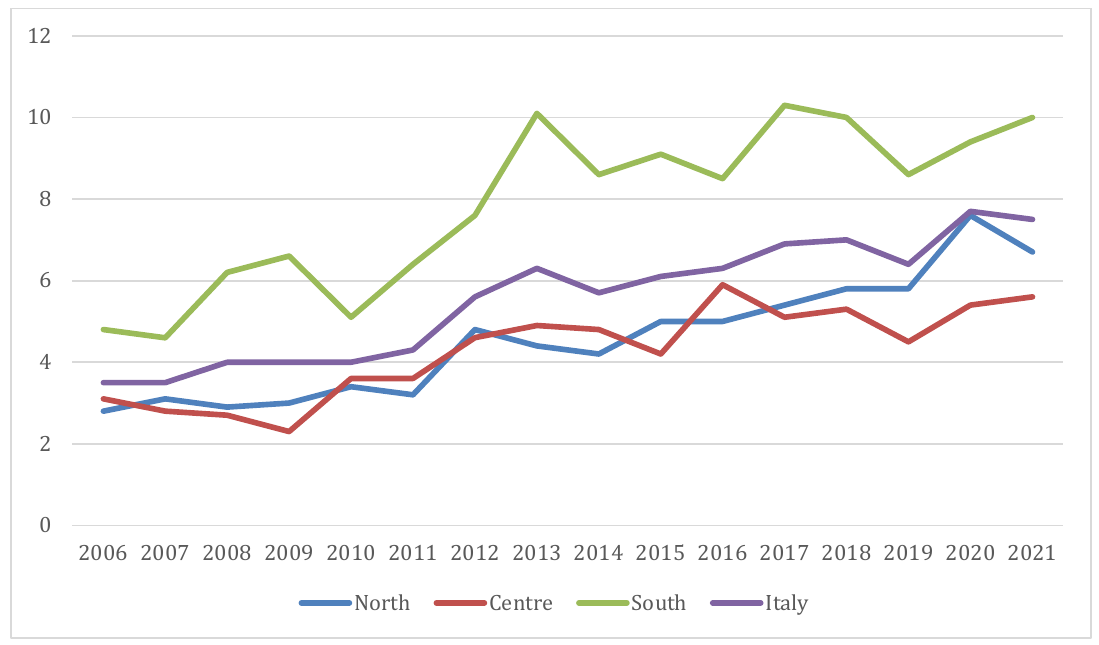
024681012 Figure 1. Poverty rate trends in Italy, 2005–2021. Source: own elaboration on the Istat database. From 2020, the poverty rate decreased by 0.2 percentage points for individuals and kept the same percentage for households. The rate in southern Italy increased from 9.4% to 10% for individuals and from 11.1% to 12.1% for households. The latter are the largest poverty values in Italy (Figure 2). Figure 2. Poverty rate trends among households and individuals, 2020–2021. Source: own elaboration on the Istat database. The poverty rate has been increasing for minors (0–17 years old), from 13.5% in 2020 to 14.2% in 2021. As with the other age cohorts, a slight growth (+0.2 percentage points) was also evident for those of a working age (18–64 years old) (Figure 3).